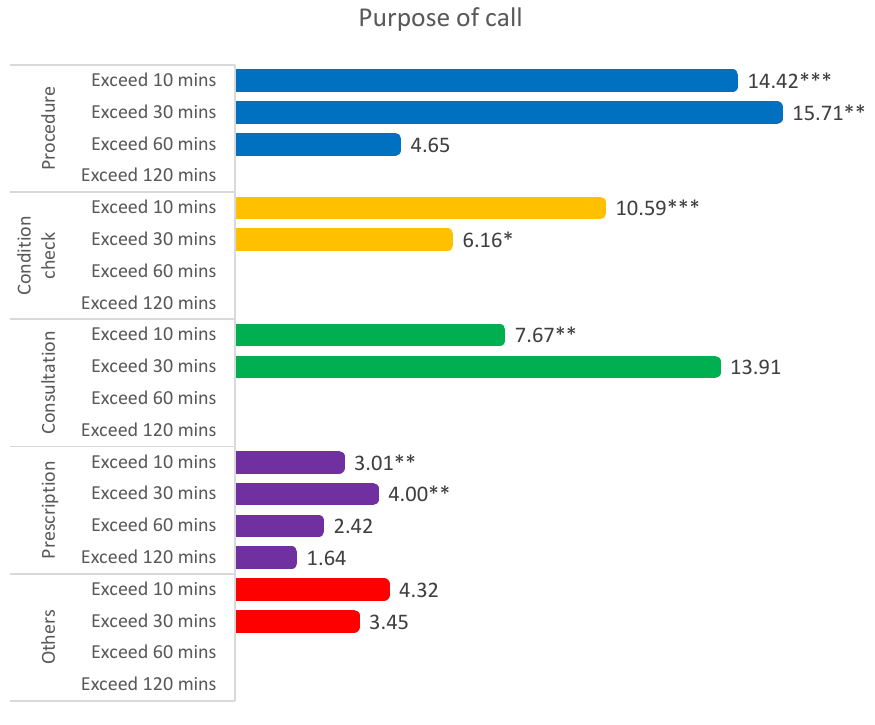
Figure 1. Results of subgroup analysis on the time to response a medical call of non-hospitalist compared to hospitalists: purpose of a medical call (reference: hospitalist, less than 10 min; shown in odds ratio). *** p < 0.001, ** p < 0.01, * p < 0.05.